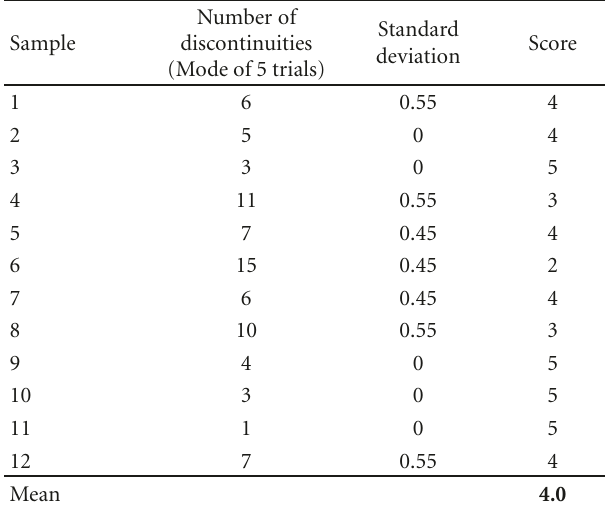
Table 5: Tree growth model quality scores for the twelve Grissino- Mayer samples. Here, the variable frequency spacing filterbank was used (see Table 2 for the